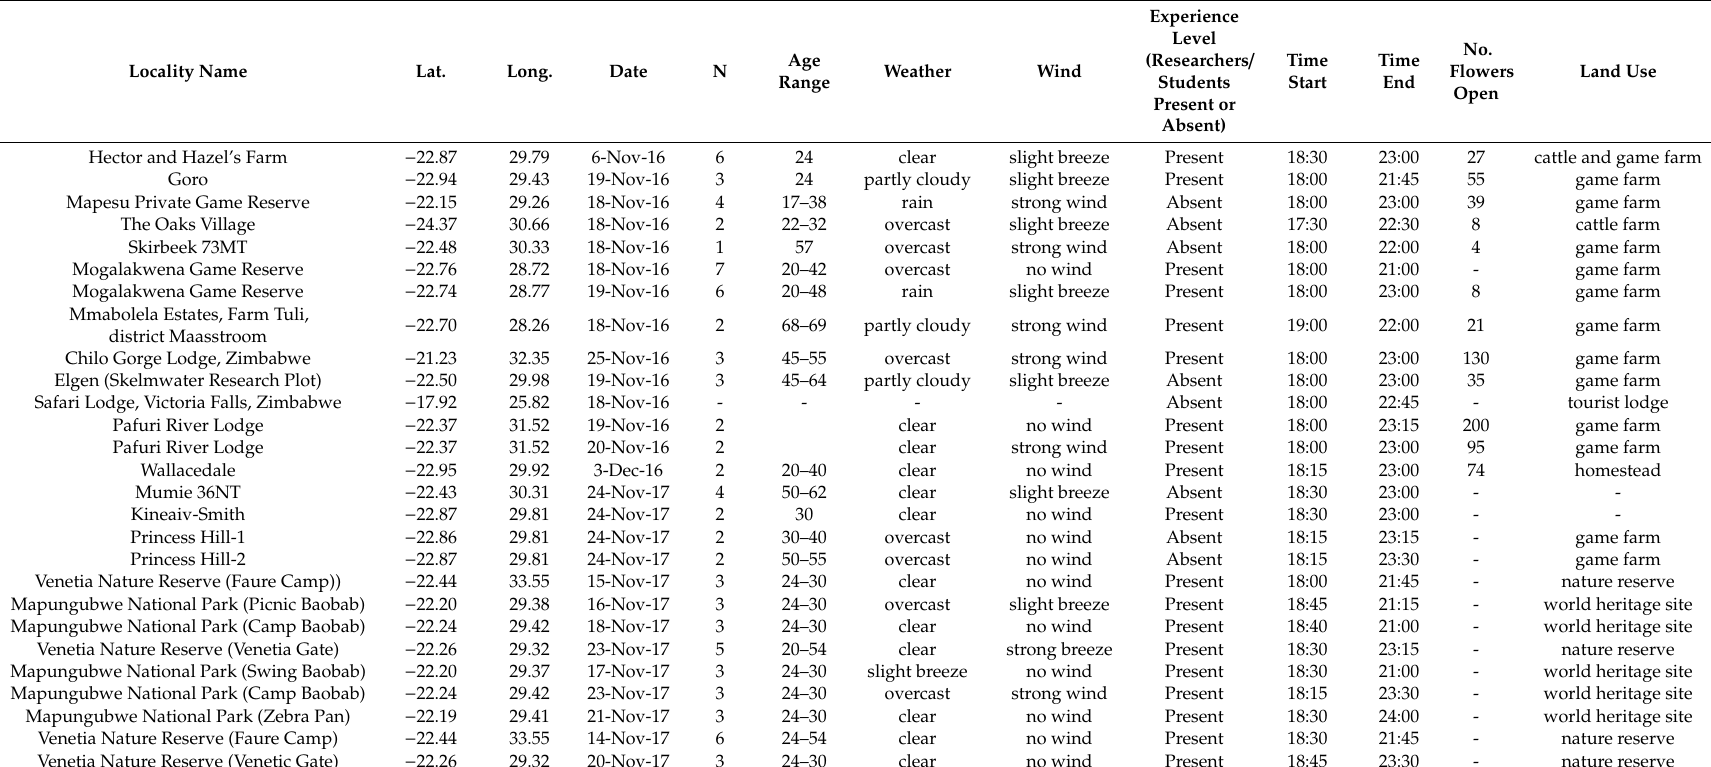
Table 1. Details of 27 nights recorded at 23 Baobab tree locations during 2016 and 2017, where citizen scientists conducted observations of flower visitors as part of the “Baobab Blitz” project. N refers to number of observers. Where multiple locations were recorded within protected areas, particular locations are noted by abbreviated codes in